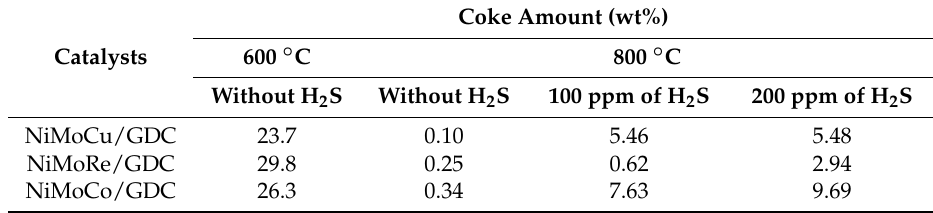
Table 1. Coke amount over catalysts after reaction in presence of H 2 S, measured by TG-DSC analysis.